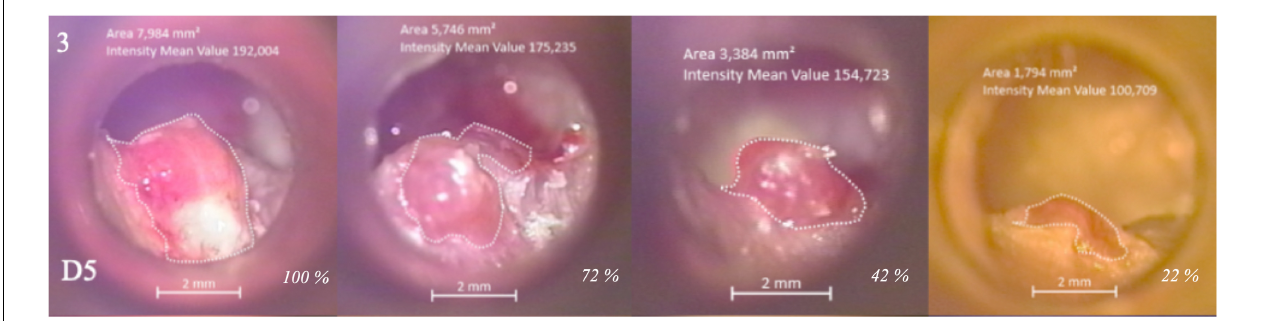
FIGURE 2 | Chronic postoperative temporal bone cavity inflammation focus surface area measurements. Otomicroscopical photographs of CPTBCI (i.e., chronically discharging radical mastoid cavity) in a patient at four checkups depict surface areas (mm 2 ) transformed to percentages (italics) according to the baseline. The figure represents a regression of inflammation (i.e., spherical granulation) in a patient treated with PVRP. D5 marks the anatomical area of CPTBCI focus according to the anatomical classification ( Supplementary Material 2 ) and in the upper left corner, an ID of the patient ( Supplementary Materials 7–10 ). CPTBCI: chronic postoperative temporal bone cavity inflammation; PVRP: platelet- and extracellular vesicle-rich plasma.